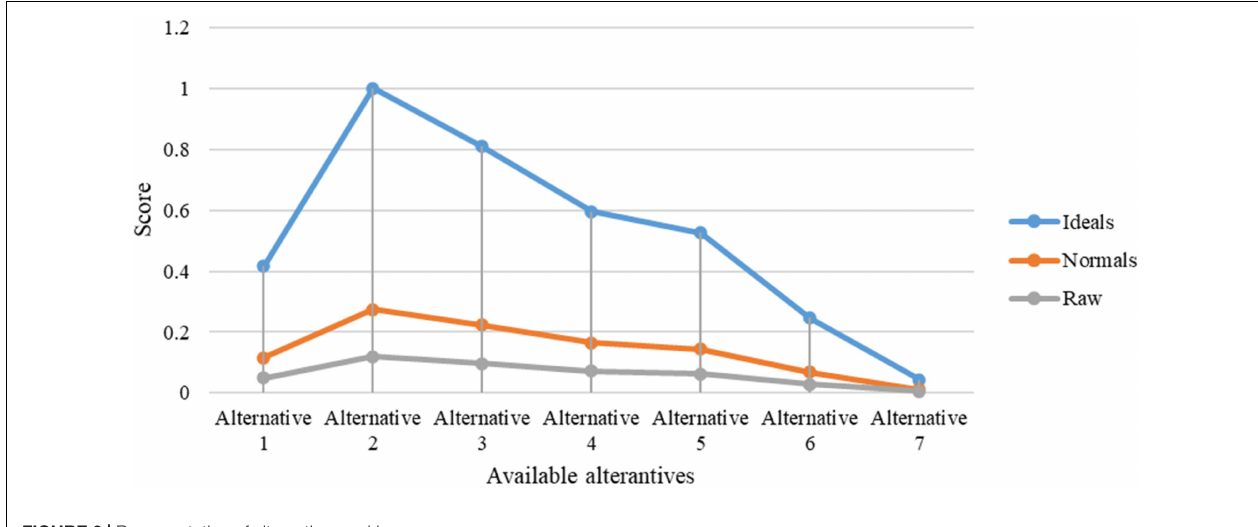
FIGURE 3 | Representation of alternatives ranking.